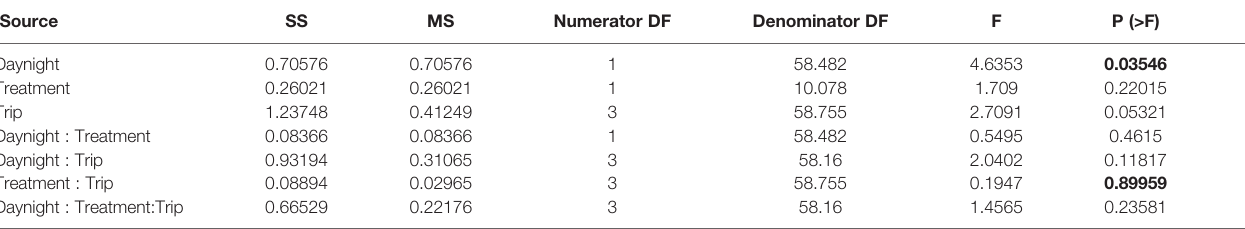
TABLE 5 | Linear mixed effects model for zooplankton Shannon diversity index.